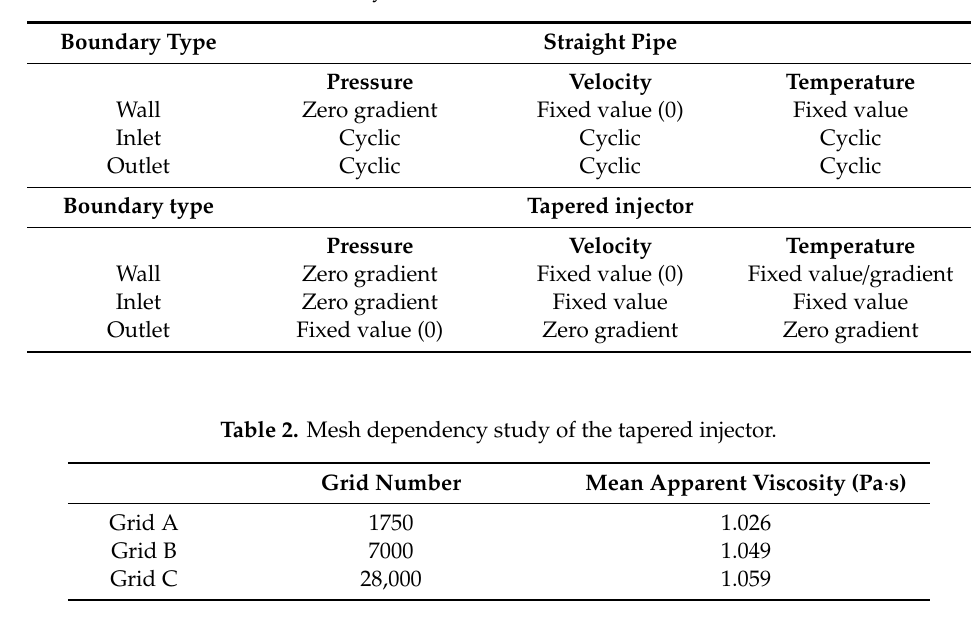
Table 1. Boundary conditions for the numerical simulations.